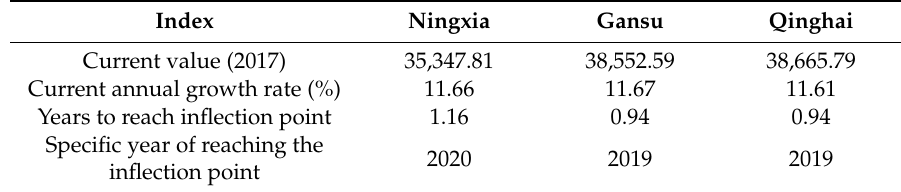
Table 8. Summary of values for Ningxia, Gansu, and Qinghai detailing the time required to reach the inflection